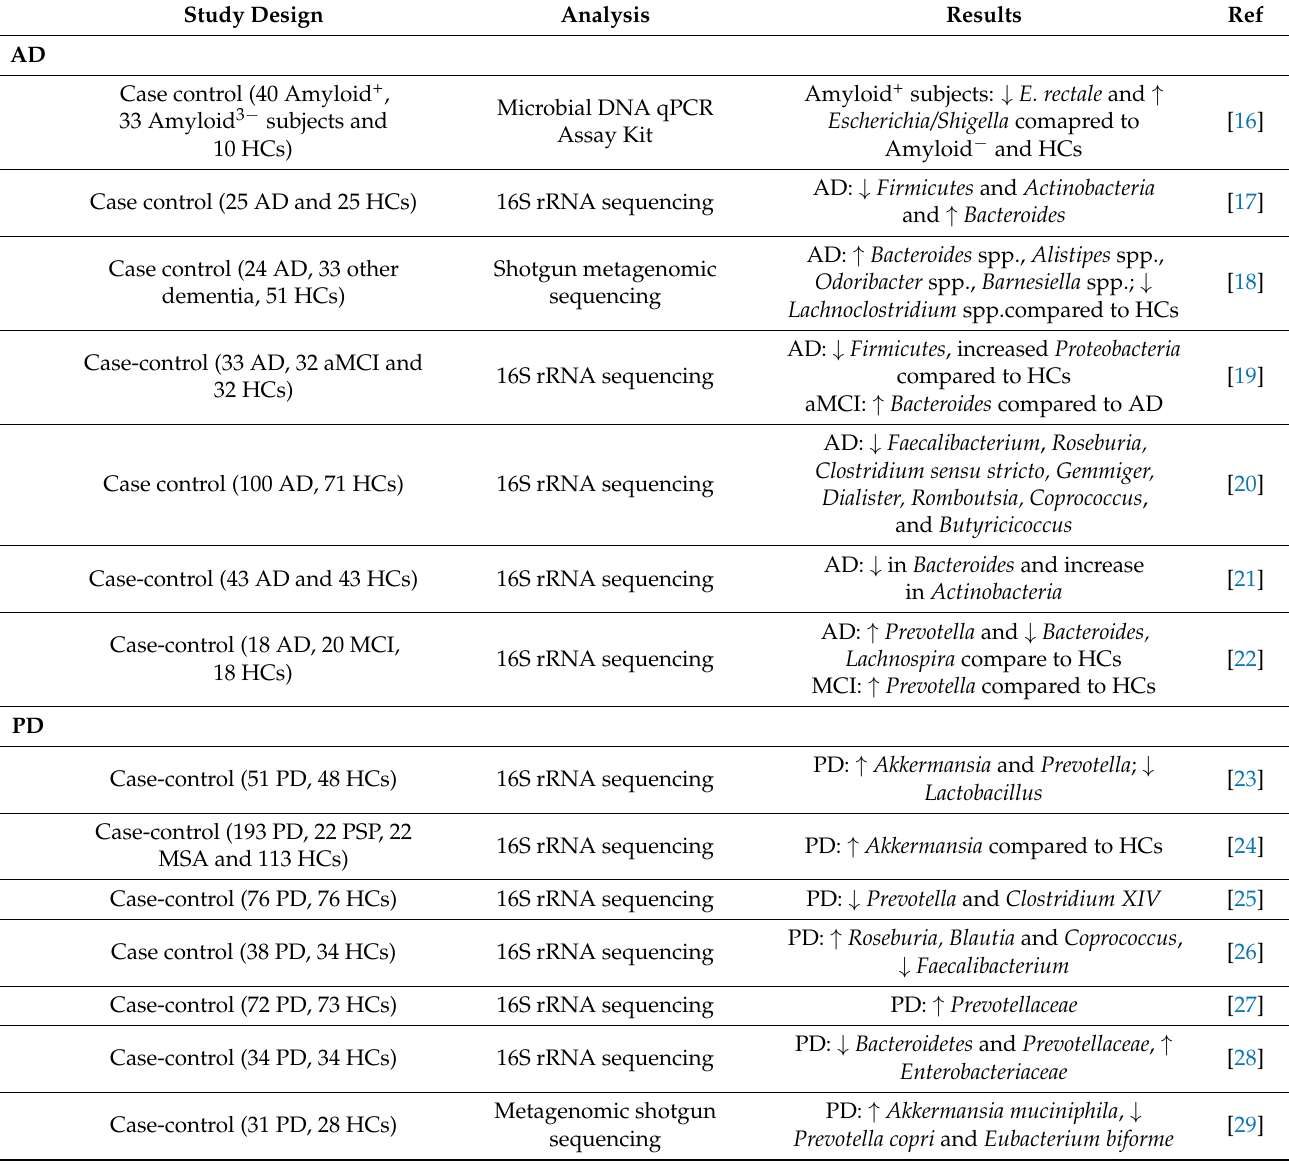
Table 1. Human studies on the gut microbiome in neurodegenerative diseases. AD: Alzheimer’s disease, PD: Parkinson’s disease; ALS: Amyotrophic lateral sclerosis; HCs: Healthy controls; MCI: Mild cognitive